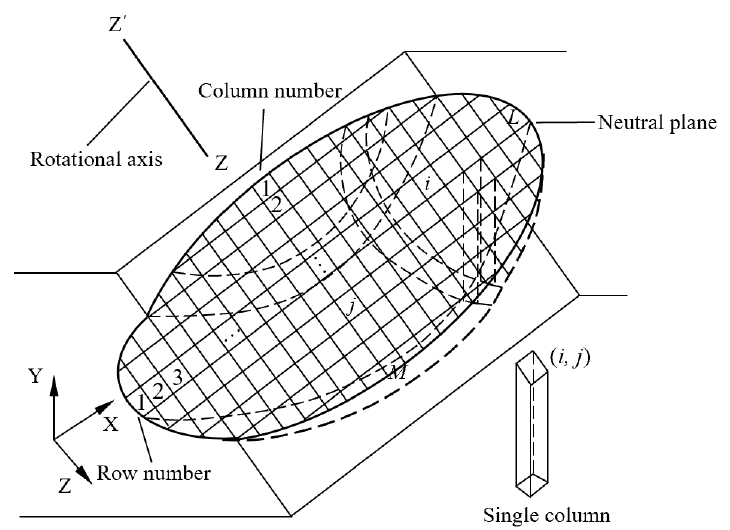
Figure 1. Meshing grid of sliding mass with coordinate system.